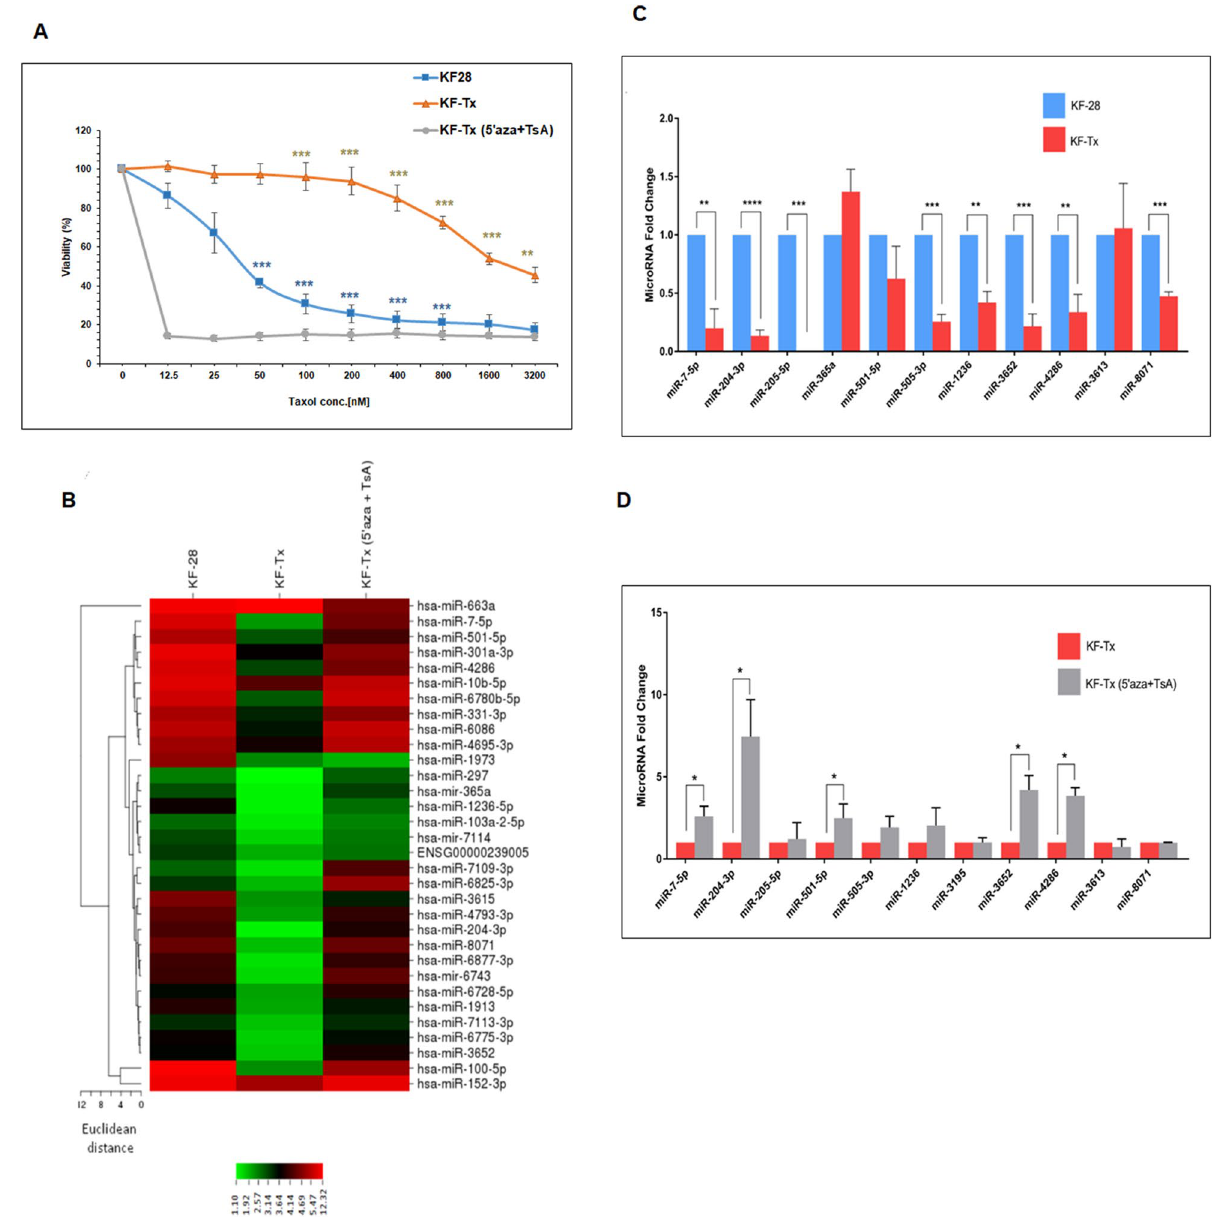
Figure 1. MiRNA profiling of taxol responsive (KF-28) and resistant (KF-Tx) OC cells. ( A ) Confirmation of chemoresistance of KF-Tx cells to PTX. The figure shows the differential response to PTX and the ability of the epigenetic modulators to restore sensitivity to PTX. ( B ) Heat map showing differentially expressed miRNAs in the PTX responsive, KF-28, cells versus PTX-resiatnt, KF-Tx, cells, and in KF-Tx cells versus KF-Tx cells following tratement with 5 ′ AZA and TsA. ( C ) QPCR analysis result of the selected micorRNAs to confirm their downregulation in KF-Tx cells. ( D ) Relative expression of the same set of miRNAs in KF-Tx cells before and after co-treatment with 5 ′ AZA (10 µM; 3 days) and TsA (300 nM; one day). U6 was used as a control. Values in A, C and D are means ± SE from tree independent experiments. One way anlysis of variance (ANOVA) was performed to get the satsitical significance of diffrence at each point (* p < 0.05, ** p < 0.01 and *** p <